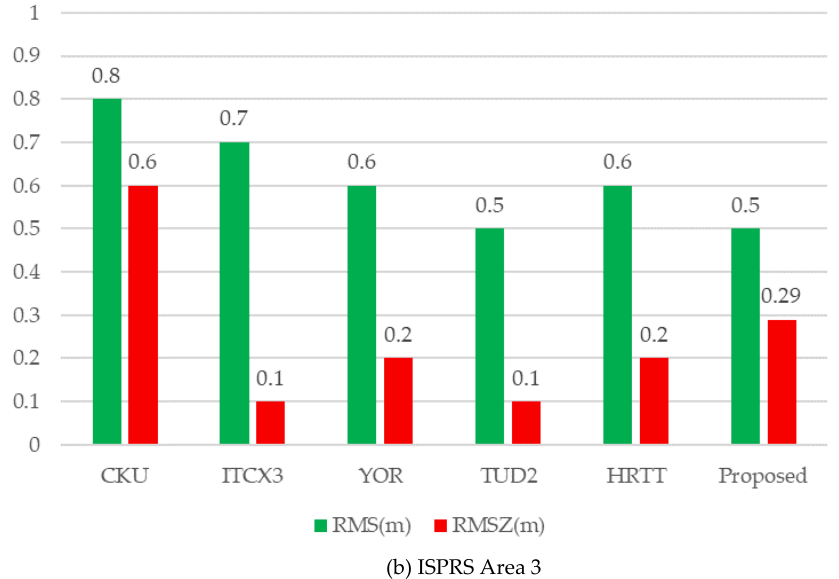
Figure 16. Geometrical accuracy comparison of the reconstructed models. The CKU [79], ITCX3 [5], YOR [80], TUD2 [50], and HRTT [54] are shorts for participant.